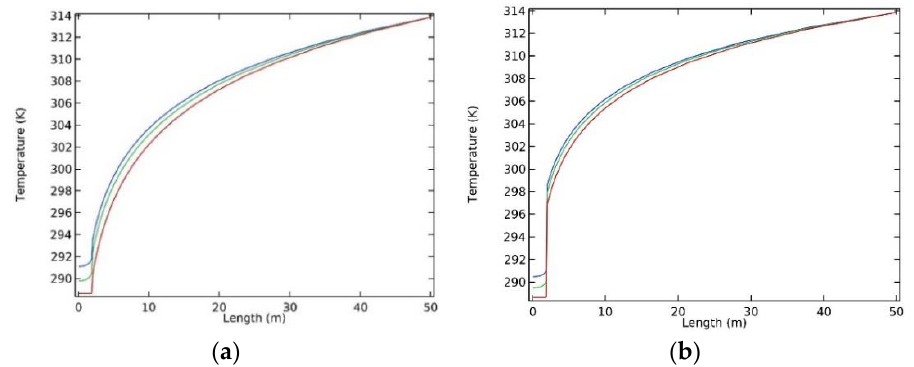
Figure 10. Changes of the internal temperatures of support materials along their centreline: ( a ) Change of the internal temperature of the common sprayed concrete; ( b ) Change of the internal temperature of the heat-insulating materials doped with basalt fibres.